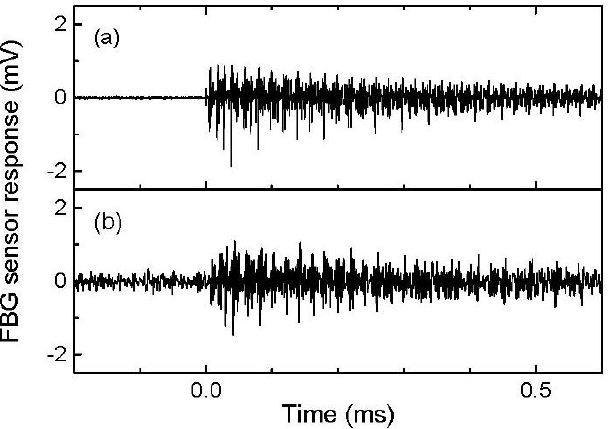
Figure 7. The ultrasonic responses of an FBG sensor with a resonant length of 50 mm.